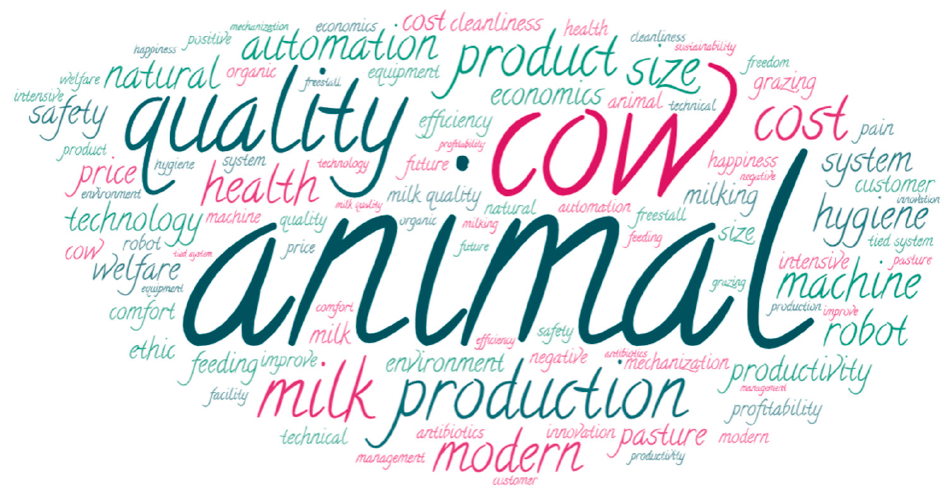
Figure 4. A keyword cloud created on the basis of Polish students’ answers to three questions about the ideal dairy farm.